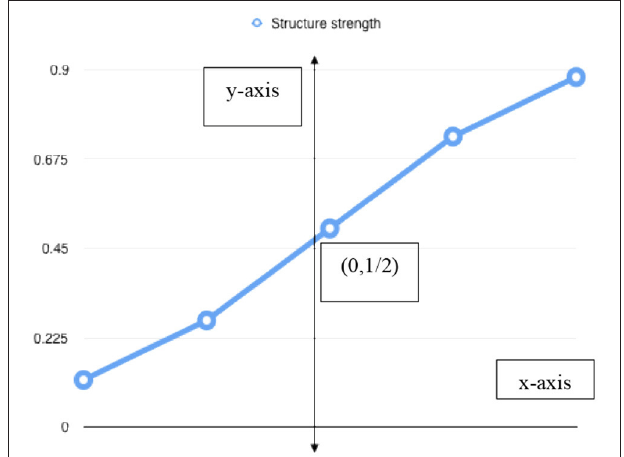
FIGURE 4 | A Monte Carlo simulation of Equation (16) with the y-axis intercept at (0, ½ ) in the center, with y ranging from 0 to left side). From the y intercept to the right along the x -axis (with x units) represents increasing effort and emotion; from the left of the intercept along the x -axis represents stability and a team’s ground state (where x -1, 0 units). As the effort to maintain a team’s structure approaches zero in the middle of the graph, a critical point is reached. As more effort is required to hold the team’s structure together (i.e., moving to the right), it begins to break apart as team members begin to act more and more like redundant, independent